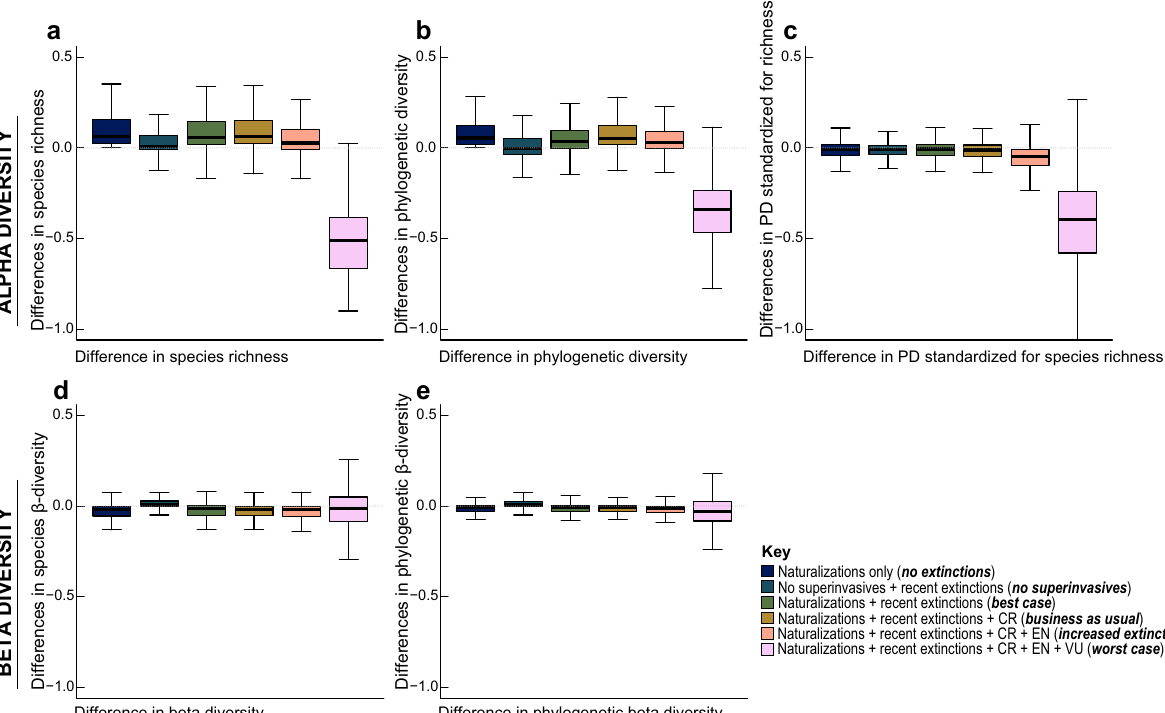
Fig. 3 Changes in plant communities under various scenarios of extinctions and naturalizations in the Anthropocene. Top row a ( n = 13,218 grid cells), b ( n = 13,218 grid cells), and c ( n = 13,218 grid cells) shows the differences in α -diversity and bottom row d ( n = 13,218 grid cells), and e ( n = 13,218 grid cells), shows differences in β -diversity. Comparisons are made across six scenarios: i) ‘ no extinctions ’ recent naturalizations only, ii) ‘ no superinvasives ’ based on the removal of non-native species with unusually large invaded ranges, iii) ‘ Best case ’ (based on recent extinctions and naturalizations that have occurred to date), iv) ‘ business as usual ’ projected extinction of critically endangered species (CR), v) ‘ increased extinction ’ based on projected extinction of endangered (EN) and CR species, and vi) ‘ worst case ’ based on projected extinction of all threatened species including vulnerable (VU), EN and CR species. Dashed line at zero corresponds to no change. Species richness was calculated as the numbers of species within 100 km × 100 km grid cells. Phylogenetic diversity was calculated as the sum of all phylogenetic branch lengths for the set of species within each grid cell. The bottom and top of boxes show the fi rst and third quartiles respectively, the median is indicated by the horizontal line, the range of the data by the whiskers. The dataset used for the analysis included 205,456 native species, 1065 recently extinct species, extinction projections for 150,000 species, and 10,138 naturalized species. Source data are provided as a Source Data fi